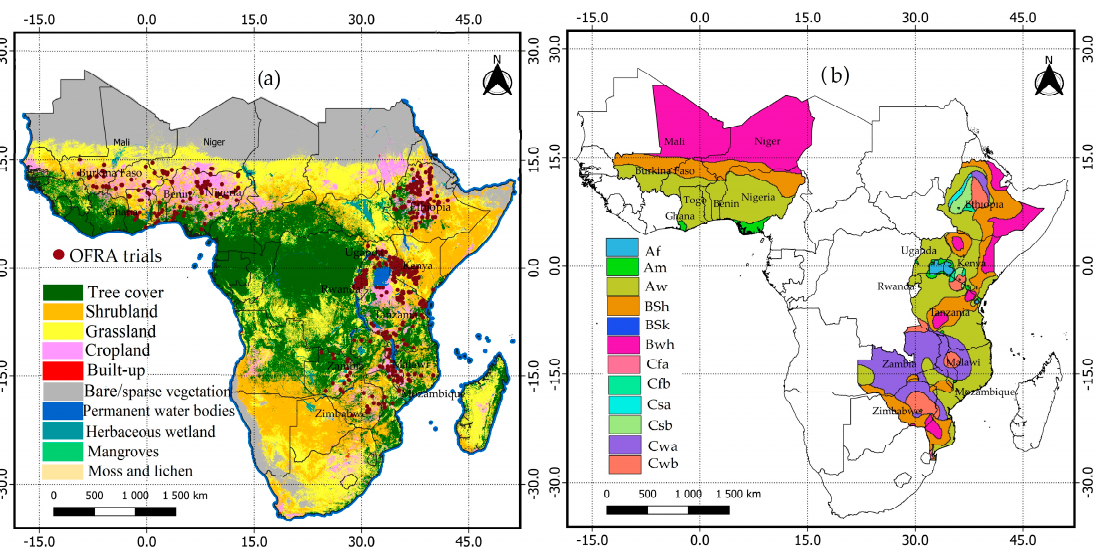
Figure 1. Distribution of OFRA field trials in land and use and cover of Sub-Saharan Africa ( a ), Climate zones of selected 16 countries under optimized fertilizer recommendation rate in Africa (OFRA) ( b ), Af: Tropical rainforest, Am: Tropical monsoon, Aw: Tropical Savannah, BSh: Arid Steppe Hot, BSk: Arid steppe cold, BWh: Arid desert hot, BWk: Arid desert cold, Cfa: Temperate hot summer without dry season, Cfb: Temperate warmer summer without dry season, Csa: Tem- perate dry summer and hot summer, Csb: Temperate dry summer and warm summer, Cwa: Tem- perate warm and hot summer, Cwb: Temperate warm summer [28]. Land use and land cover was extracted from the European Space Agency (ESA) WorldCover 10 m 2020 product [30]. OFRA (op- timized recommendation fertilizer rate in Africa) was downloaded. Table 1. Soil properties and crop water requirement.